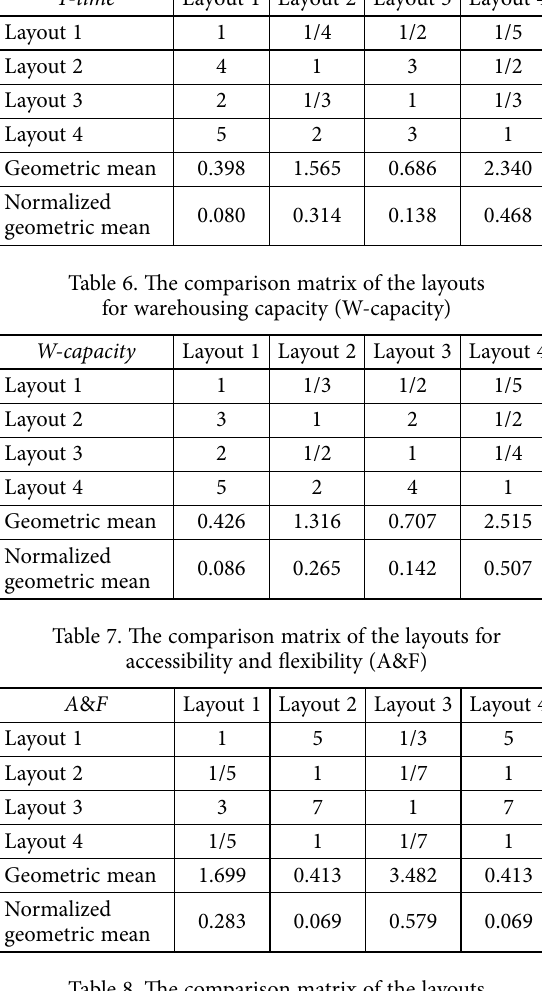
Table 8. The comparison matrix of the layouts for traffic and area